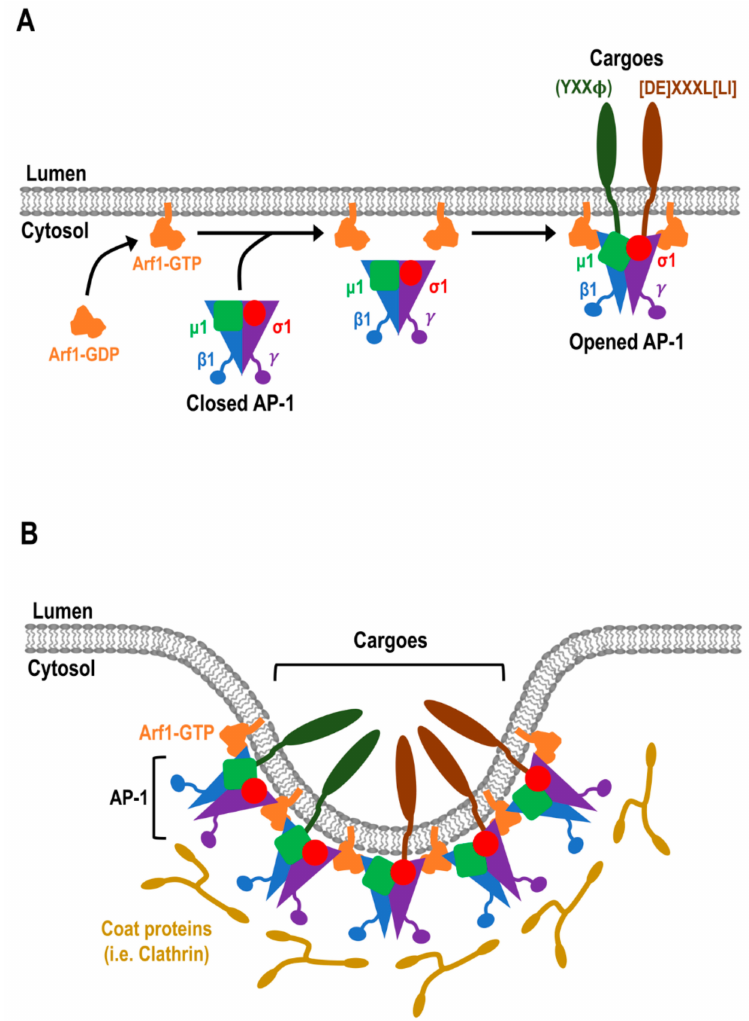
Figure 2. Cargo sorting at the TGN: ( A ) schematic showing the process of membrane recruitment of the adaptor protein complex, AP-1, and the binding of sorting motifs on the cytoplasmic tail of cargoes. GTP-bound membrane-associated small G protein Arf1 recruits cytosolic AP-1 to the TGN membranes. Arf1 also induces conformational change in AP-1, from closed to an open conformation, to allow the binding of cargo sorting motif(s). The µ 1 subunit (green) binds tyrosine-based sorting motif (YXX Φ , green cargo) and the σ 1 − γ subunits bind dileucine sorting motif (DE)XXXL(LI), brown cargo). ( B ) Schematic representation of the membrane recruitment of AP complexes by active small G proteins, followed by binding of AP complex to the cytoplasmic tail of cargo proteins. Subsequently, the hinge-ear extensionsofeachAPcomplexmediatetherecruitmentofcoatandaccessoryproteinstodrivemembrane curvature and vesicle